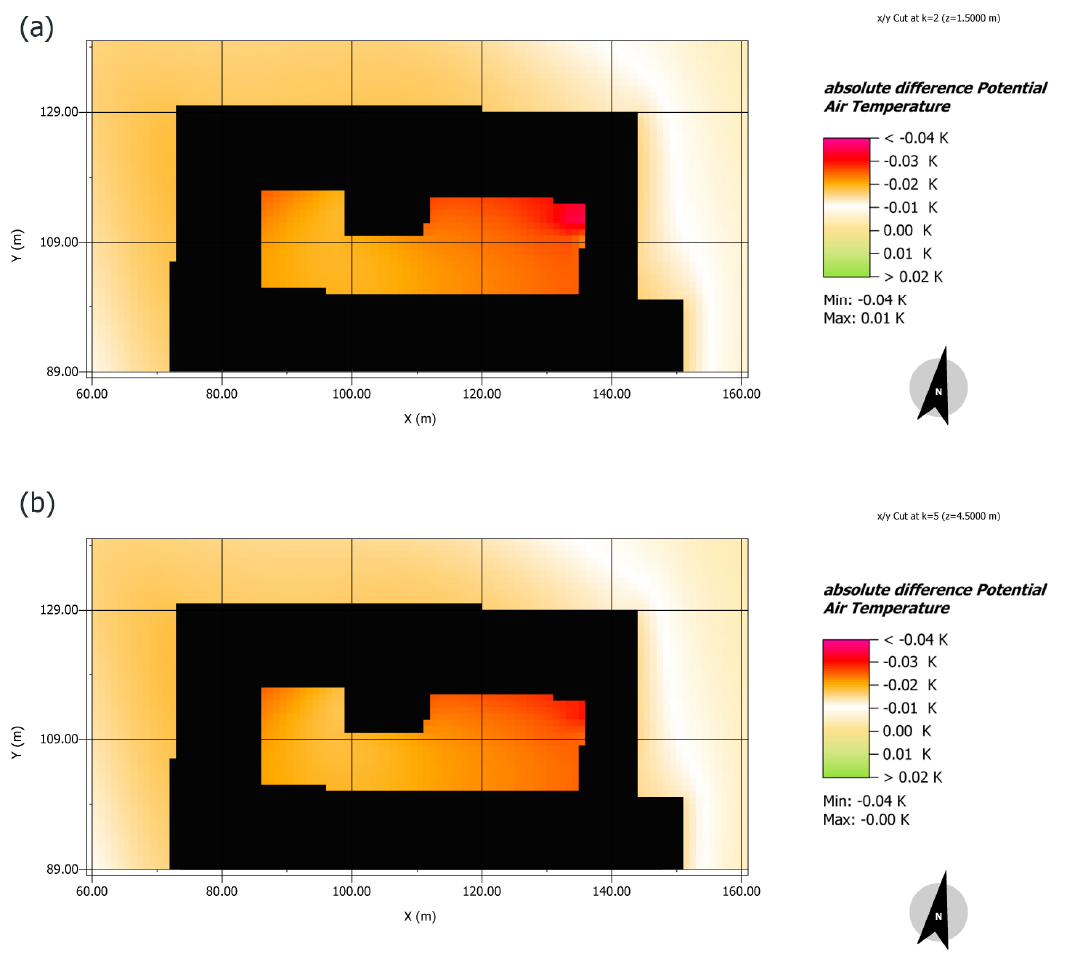
Figure 14. The initial state and green roof air temperature difference comparison in horizontal cross sections at the height of 1.5 m (a) and 4.5 m (b). Figure by authors.